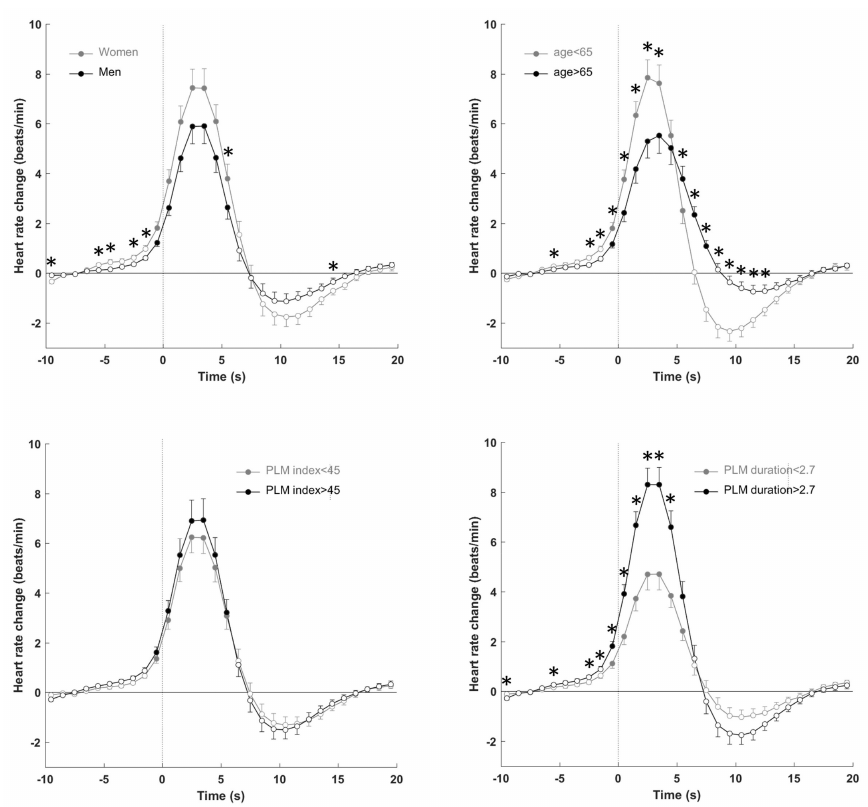
Figure 2. Heart rate response to leg movements during stage 2 according to sex, age, PLMS index, and PLMS duration. Data are presented as means ± SEM. The dashed line represents the leg movement onset. * p < 0.05 between sex, age, PLM index and PLMS duration. Filled circles indicate p < 0.05 from baseline.